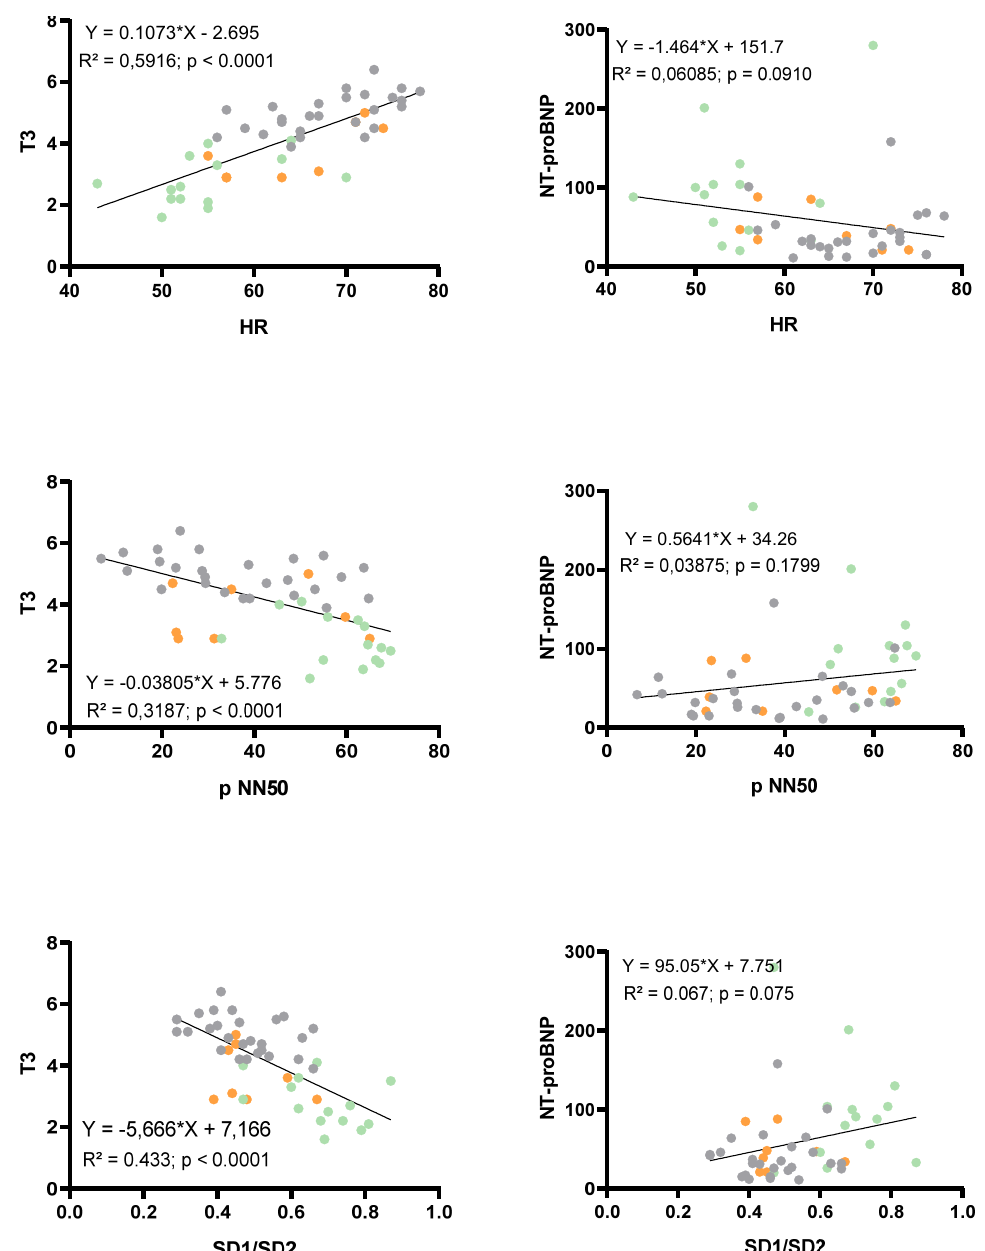
Figure 5. Relations between biological markers (T3 and NT-proBNP) and resting HR or HRV parameters (p NN50, SD1/SD2) with a single linear regression. Orange circles: AN patients with WR, green circles: AN patients without WR and grey circles: Controls. Table 3. Multivariate stepwise analysis.